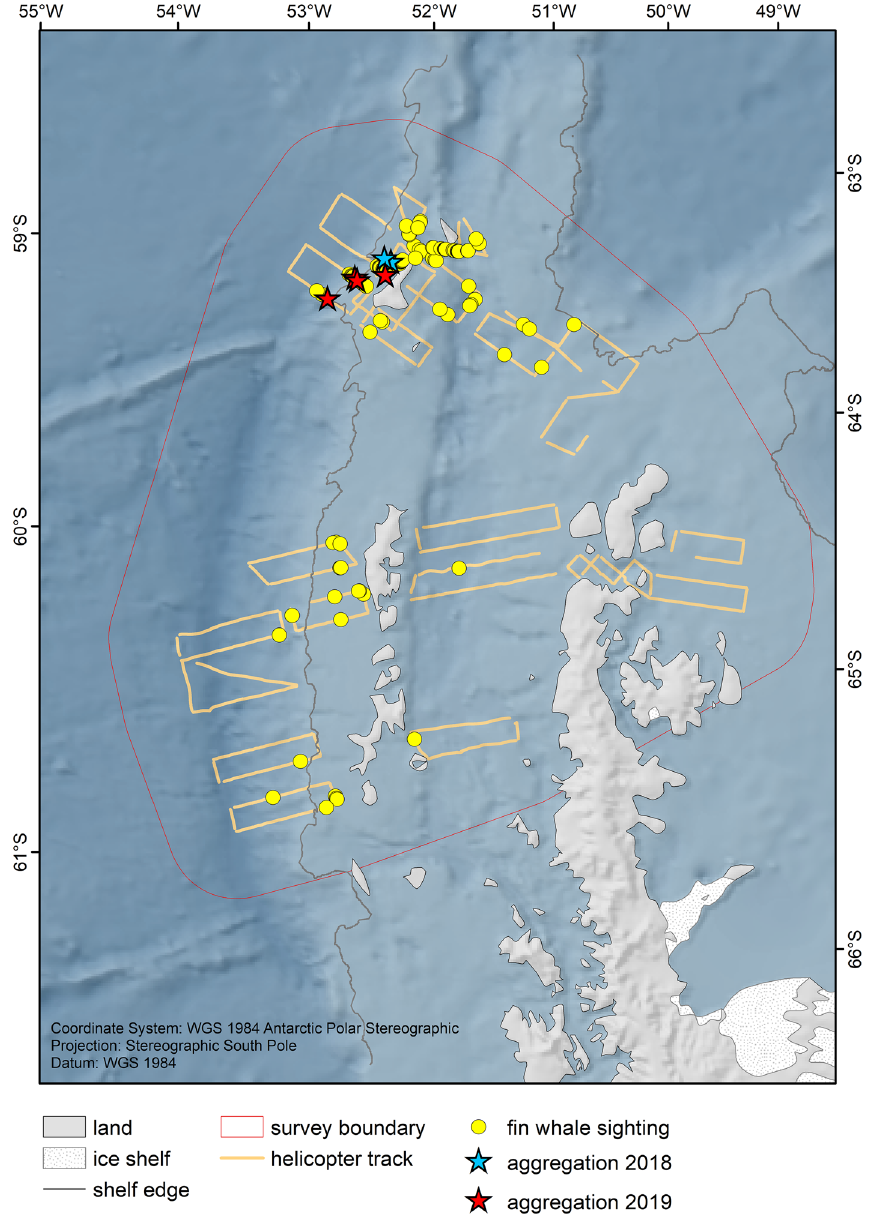
Figure 1. Survey effort and fin whale sightings. Representation of transect lines covered by the aerial survey during RV Polarstern expedition PS112. Fin whale sightings recorded on-effort during the aerial survey are indicated as yellow dots. Positions of fin whale aggregations (stars) comprise sightings collected during both expeditions. The map was composed using ESRI ArcGIS 10.6 (https:// www. esri. com/ en- us/ arcgis/ produ cts/ arcgis- deskt op/ resou